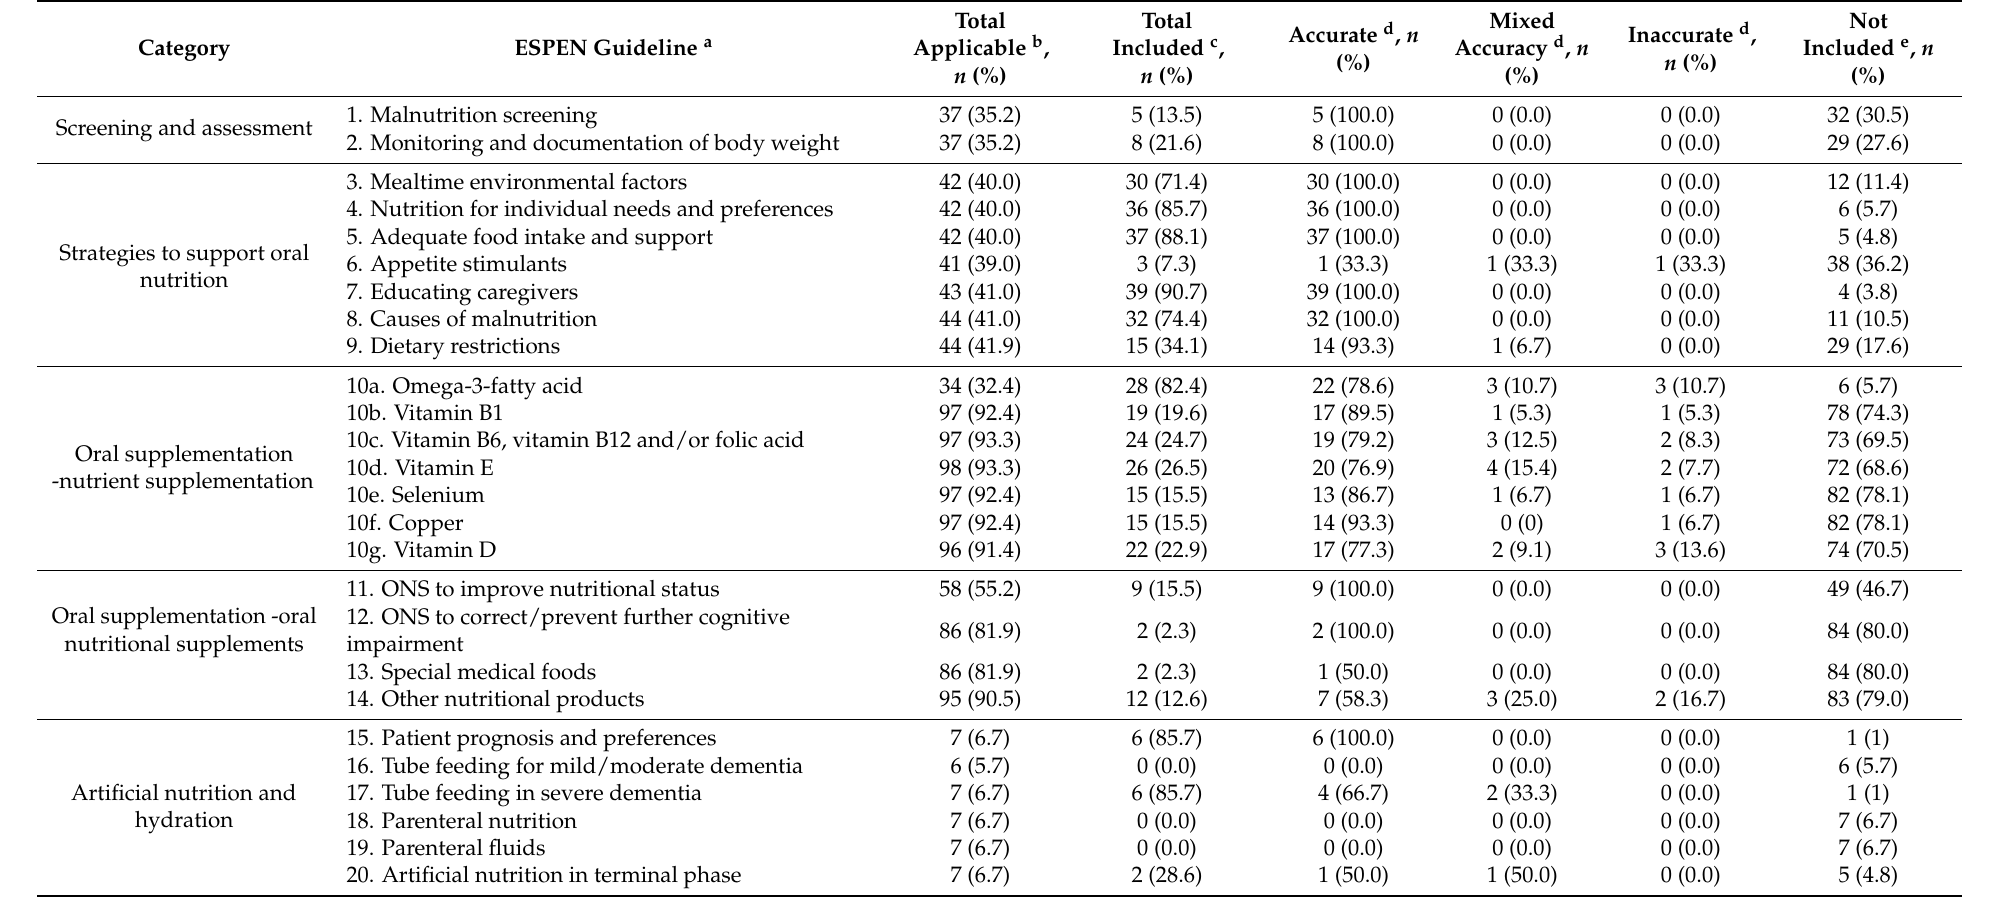
Table 3. Webpages n (%) and accuracy of included information related to the European Society for Clinical Nutrition and Metabolism (ESPEN) guidelines on nutrition in